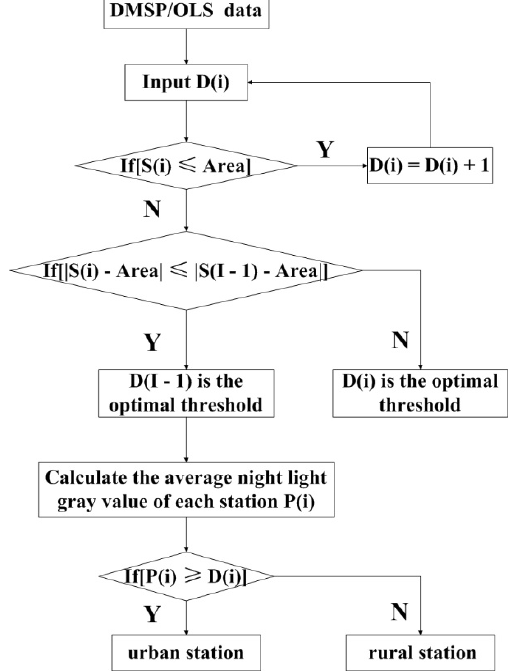
Figure 2. A flowchart of urban station and rural station division.